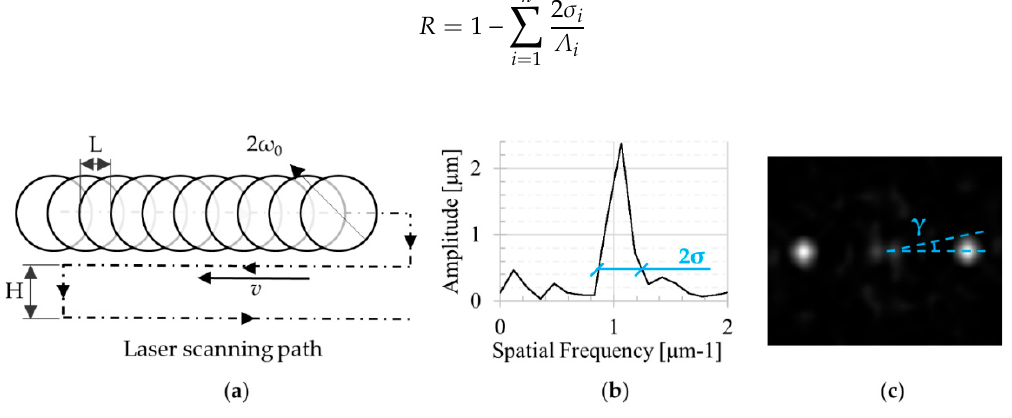
Figure 3. ( a ) Scanning path for the laser surface structuring (clarity dimensions are not correctly scaled); ( b ) FWMH (Full Width at Half Maximum) evaluation by the horizontal profile extracted from the 2D FFT of the AFM point clouds; ( c ) representative 2D FFT micrographs describing the dispersion angle.